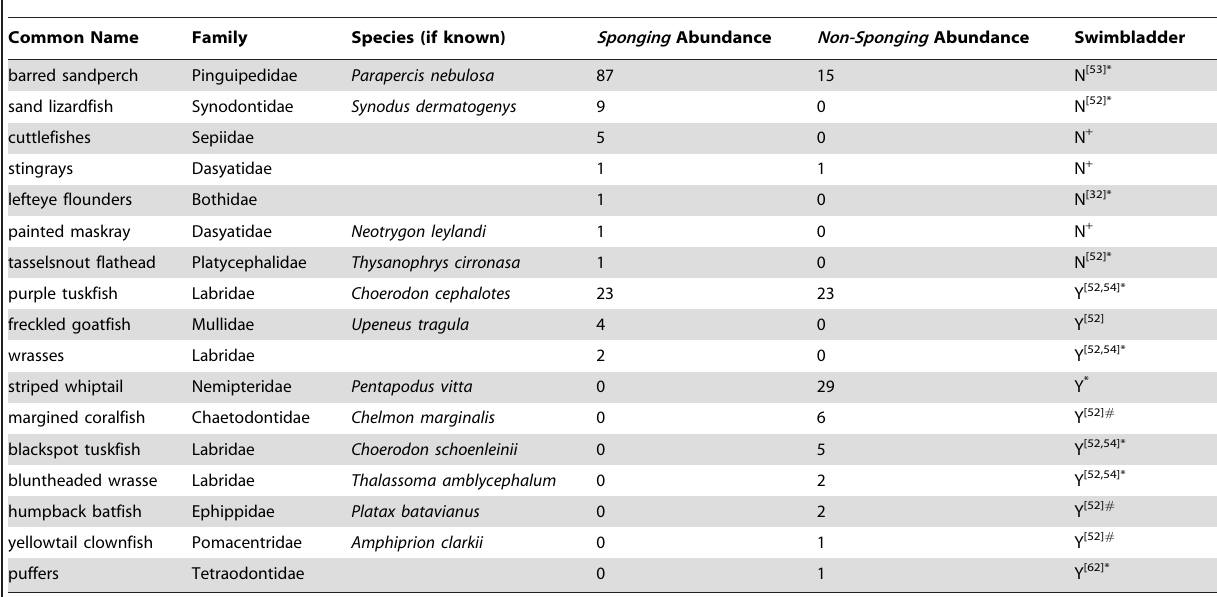
Table 1. Prey abundance from Sponging and Non - Sponging , pooled from both transects and verification dives.